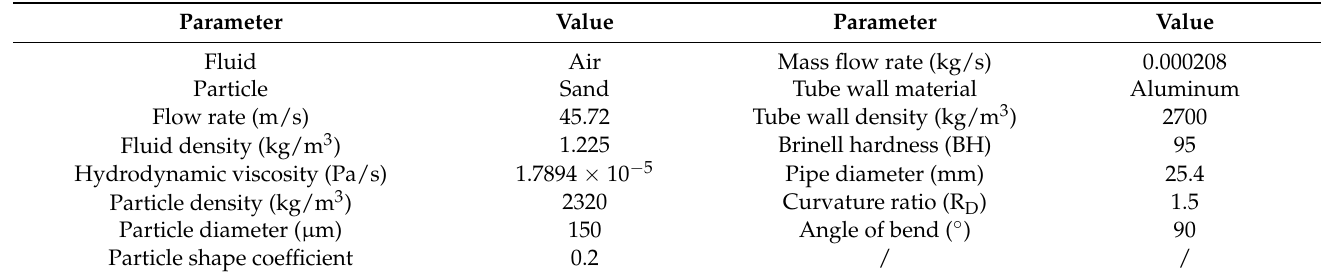
Table 4. Model parameters for